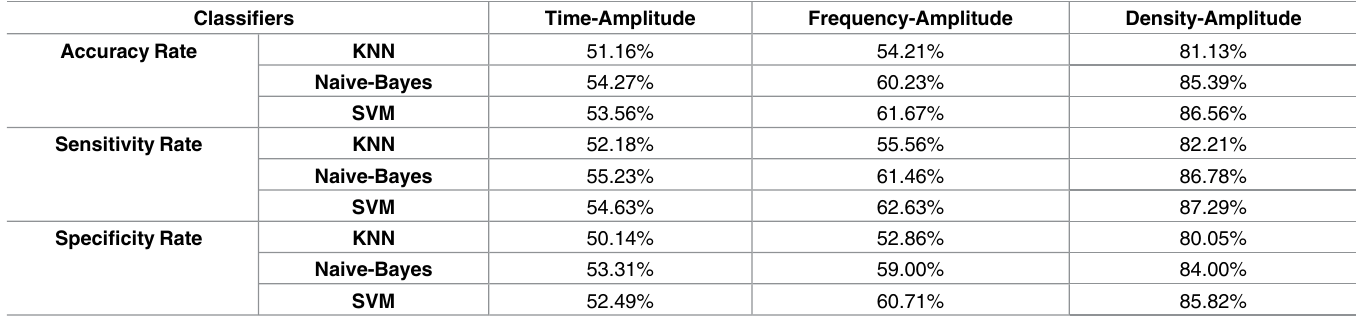
Table 4. Classification Success Rates of sEMG Datasets.